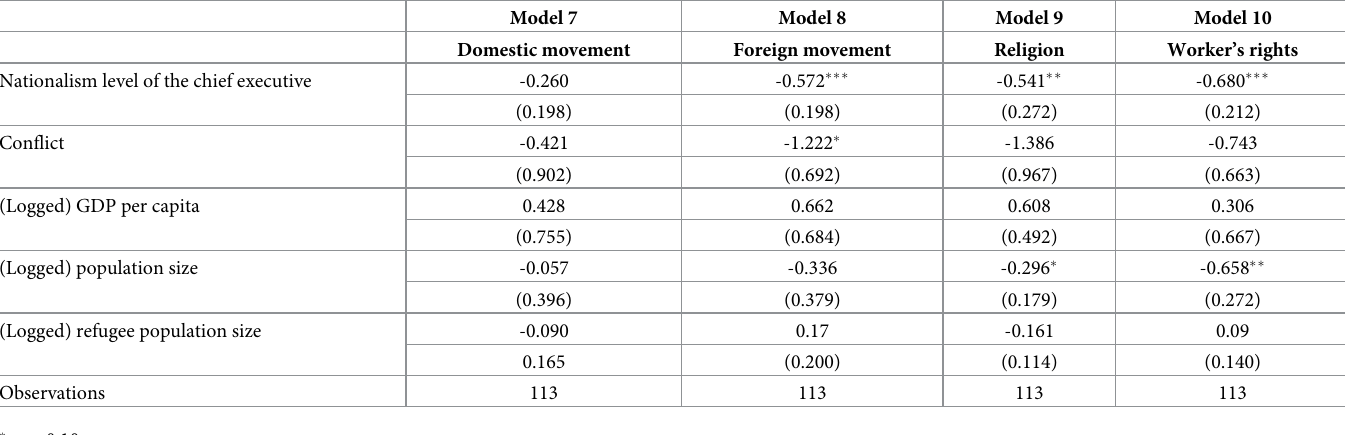
Table 3. Additional ordered logit estimates of CIRI scores in partial